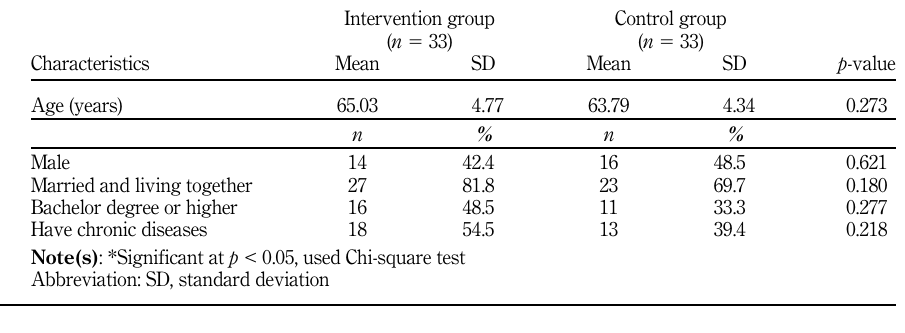
Table 2. Mean scores of knowledge, attitude and practice in smartphones usage by the study group at baseline (independent T